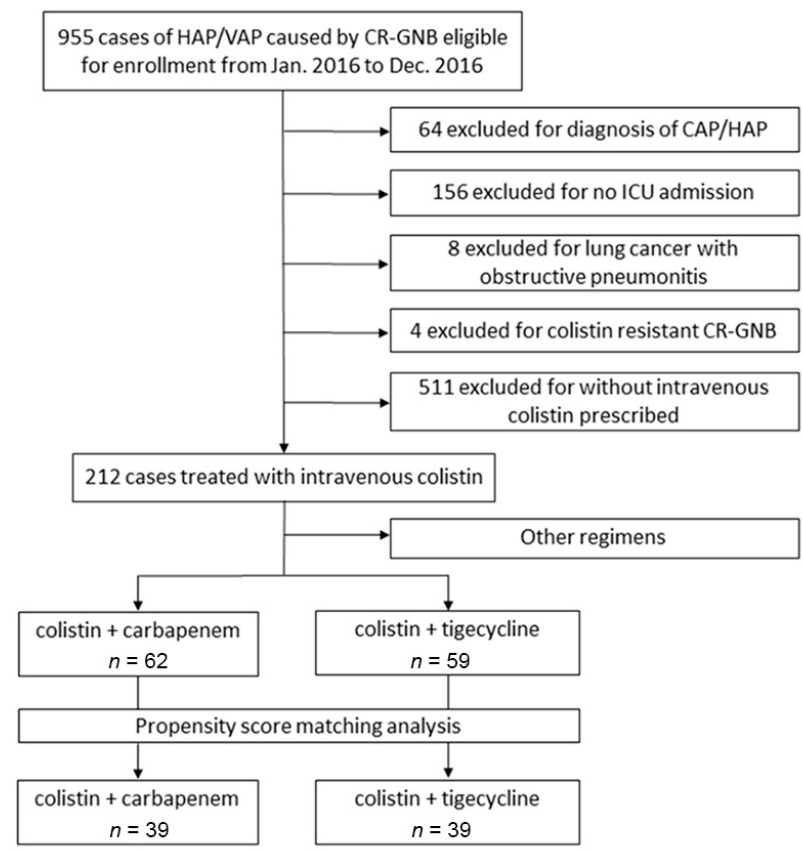
Figure 1. Flowchart showing study patient inclusion and